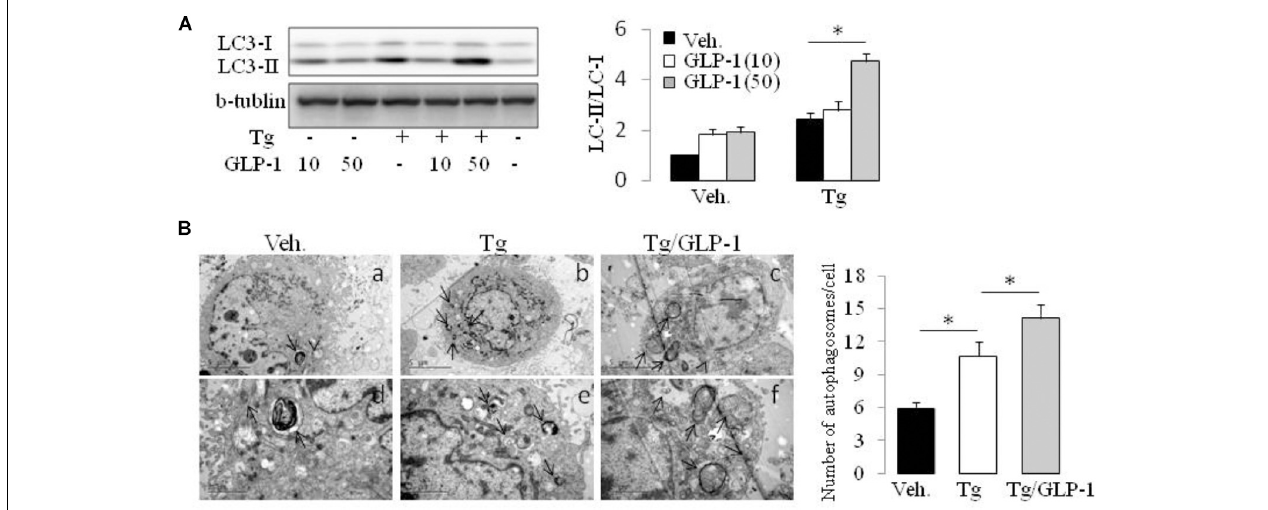
FIGURE 4 | GLP-1 promoted the autophagy process activated by ER stress. The differentiated adipocytes fasted for 16 h in low-glucose DMEM media with 0.2% BSA (fasting media) and then were treated with vehicle alone or thapsigargin (Tg) in the absence or presence of GLP-1 for 4 h. (A) Three wells of cell extracts were pooled together and were then analyzed by immunoblotting for LC3. Conversion of LC3-I to LC3-II is qualified by calculating the intensities of Western blotting. Data represent means ± SE of three independent experiments. (B) Four wells of cells were pooled together for electron microscopic analysis. Panels d to f were high magnification images of panels a to c, respectively. Typical autophagosomes (arrows) are indicated. The numbers of autophagosomes in adipocytes were calculated in a total of 15 electron microscopical sections. Data represent means ± SE. ∗ P < 0.05 and ∗∗ P <